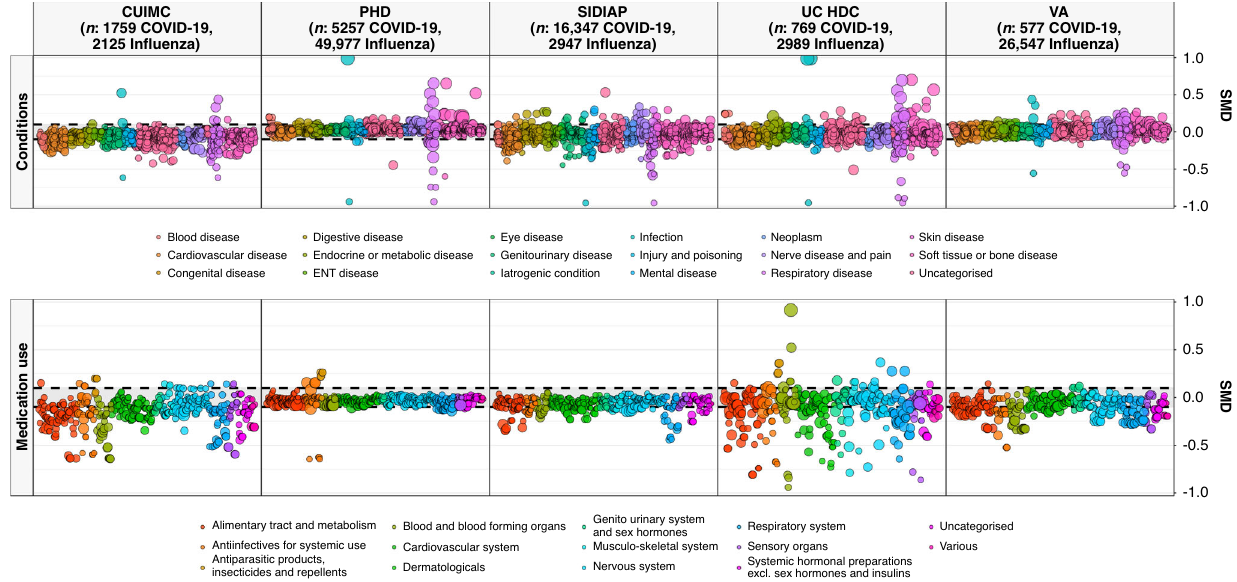
Fig. 3 Standardised mean difference in conditions (top) and medication use (bottom) among COVID-19 patients compared to 2014 – 2019 in fl uenza patients. Individuals hospitalised with COVID-19 between December 2019 and April 2020 compared with those hospitalised with in fl uenza between September 2014 and April 2019. Conditions from up to a year prior, medication use from day of hospitalisation. Each dot represents one of these covariates with the colour indicating the type of condition/medication and the size of the dot re fl ecting the prevalence of the variable in the COVID-19 study populations. CUIMC: Columbia University Irving Medical Center; PHD: Premier Healthcare Database; SIDIAP: The Information System for Research in Primary Care; VA OMOP: Department of Veterans Affairs.